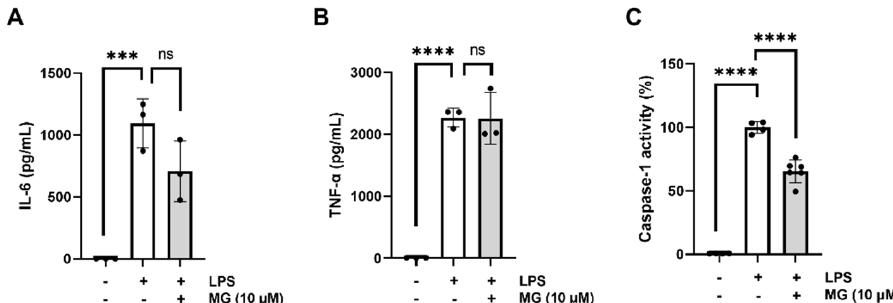
Figure 4. ( A , B ) Effect of MG on IL–6 and TNF- α production. Microglia cultures were pre-treated with MG before inducing IL–6 and TNF– α release to cell supernatants with LPS. ( C ) Inhibition of caspase–1 activity. The inhibition of the caspase-1 activity at the protein level was measured by determining the activity of purified caspase–1 in the presence (+) and absence (–) of MG (10 µM) treatment through a fluorimetric assay. Statistical significance is referred to control samples (cells pre-treated with the same DMSO% alone (–) and LPS (+)). All graphs represent mean ± s.e.m. Scatter plots represent individual values depicted as black dots. Significance levels, as calculated by one-way analysis of variance, are indicated as: ( A ) LPS untreated vs. 0 µM MG: *** p = 0.008; 0 µM MG vs. 10 µM MG: ns (no significant), p = 0.089; ( B ) LPS untreated vs. 0 µM MG: **** p < 0.0001; 0 µM MG vs. 10 µM MG: ns (no significant), p = 0.998; ( C ) LPS untreated vs. 0 µM MG: **** p < 0.0001; 0